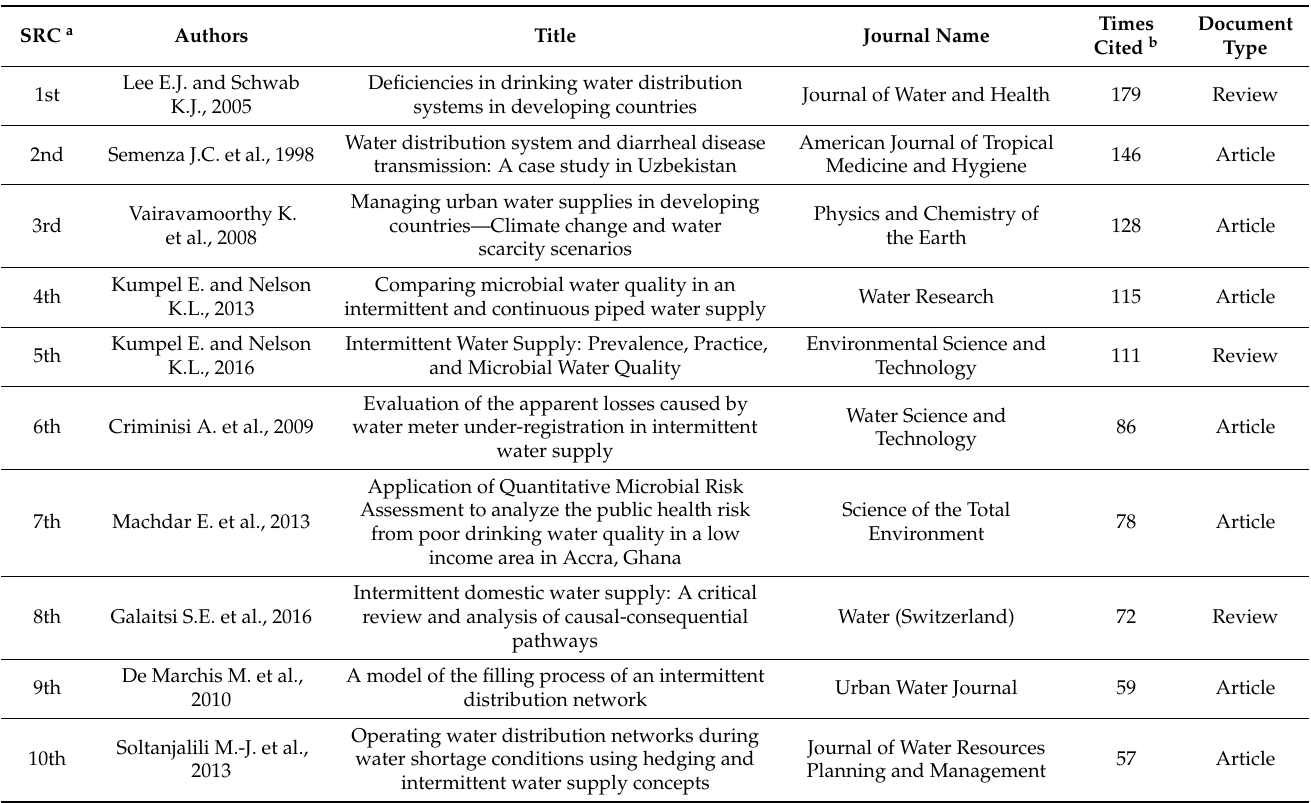
Table 5. Top 10 most-cited publications on intermittent water supply systems (IWSSs).